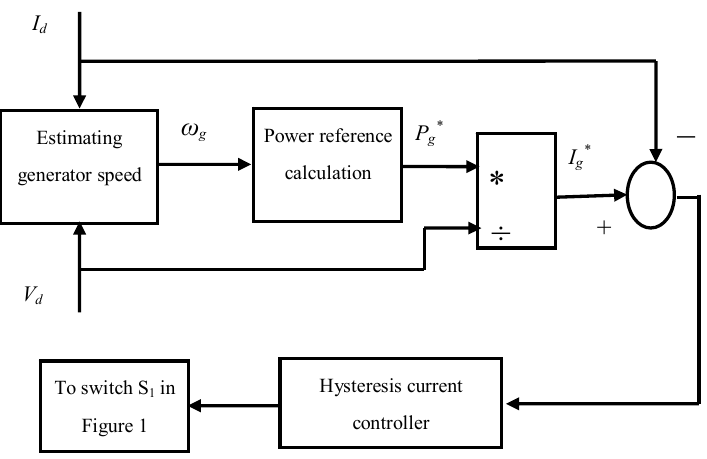
Figure 5. Estimating of permanent magnet synchronous generator speed, ω